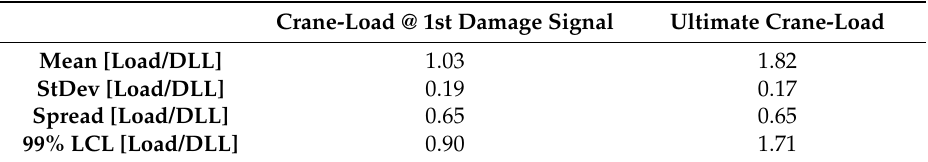
Figure 7. A schematic representation of the probabilistic assessment. ( a ) First damage AE signal distribution, ( b ) ultimate load distribution. Table 4. Summary statistics for the response variables of interest.